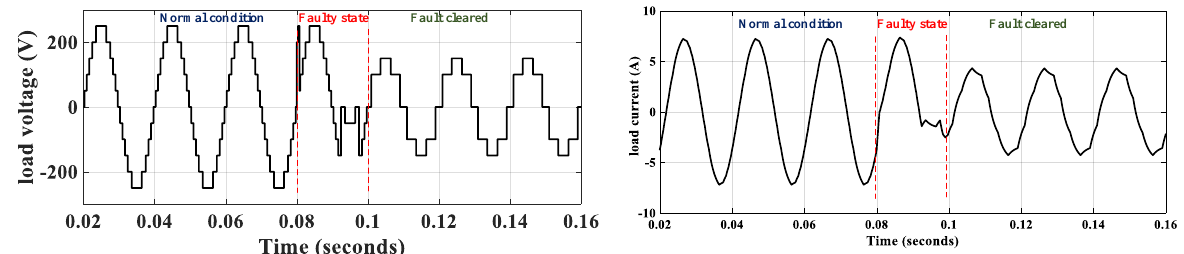
Figure 16. Simulation voltage and current waveforms under S 3 fault.